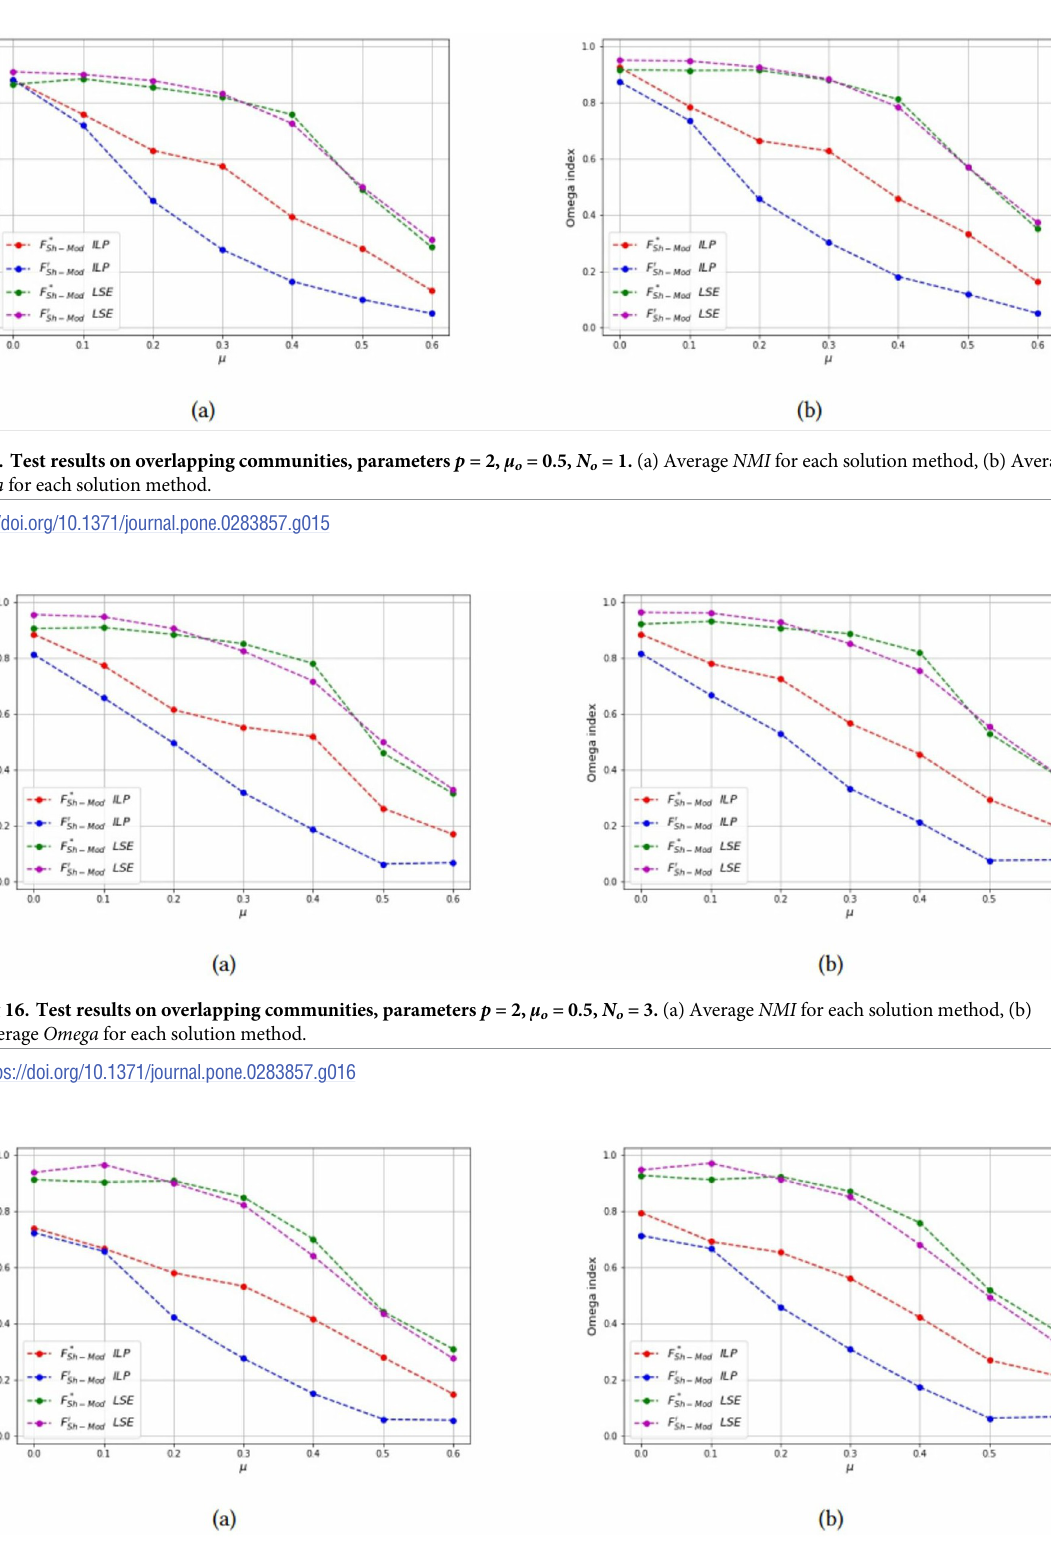
= 0.5, N = 5. (a) Average NMI for each solution method, (b) o o